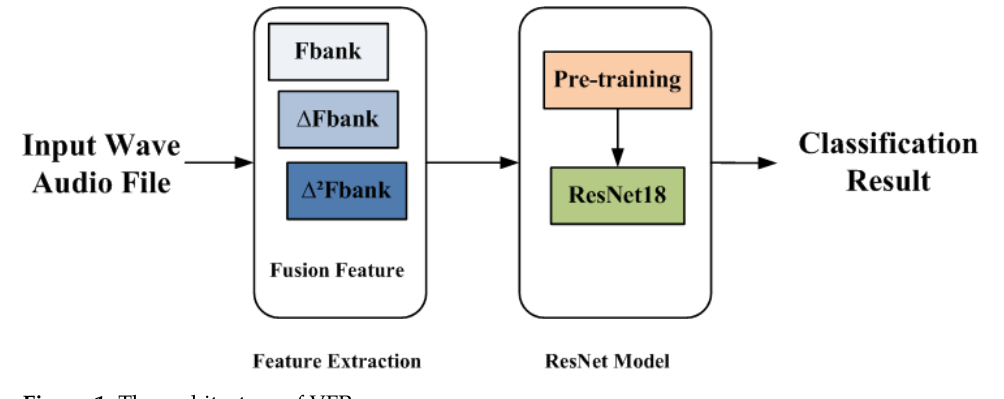
Figure 1. The architecture of